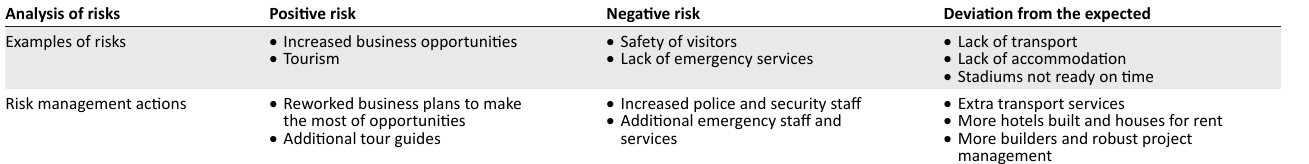
TABLE 1: A brief analysis of possible risks during the FIFA World Cup 2010. Analysis of risks Deviation from the